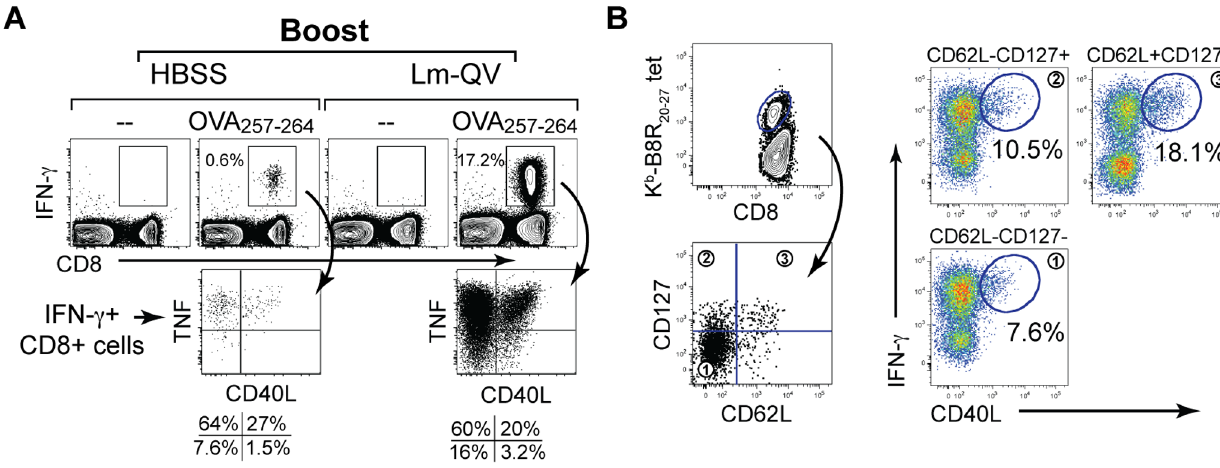
Figure 3. CD40L expressing mCD8 + T cells promote secondary expansion following homologous boost. (A) Mice primed with 10 7 cfu Lm-QV were boosted 21 days later with HBSS or 10 5 cfu Lm-QV. 5 days following boost, splenocytes were restimulated with OVA 257–264 in the presence of brefeldin A, and then stained with antibodies for CD4, CD8 (surface), IFN- c ,TNF and CD40L (intracellular). Left panels demonstrate CD40L expression in non-boosted, day 21 + 5 OVA 257–264 -specific CD8 + T cells. Right panels represent OVA 257–264 -specific CD8 + IFN- c + TNF + CD40L + cells 5 days after boosting with Lm-QV. (B) Mice were primed and boosted with 10 7 CFU Lm-QV. Five days after the boost, CD8 + B8R 20–27 -specific splenocytes were sorted into central memory (CD127 + CD62L + ), effector memory (CD127 + CD62L-) and effector (CD127-CD62L-) subsets. Sort purified cells were incubated for five hours with B8R 20–27 peptide in the presence of brefeldin A, and then stained for CD4, CD8, and intracellular IFN- c and CD40L. Data are representative of two independent